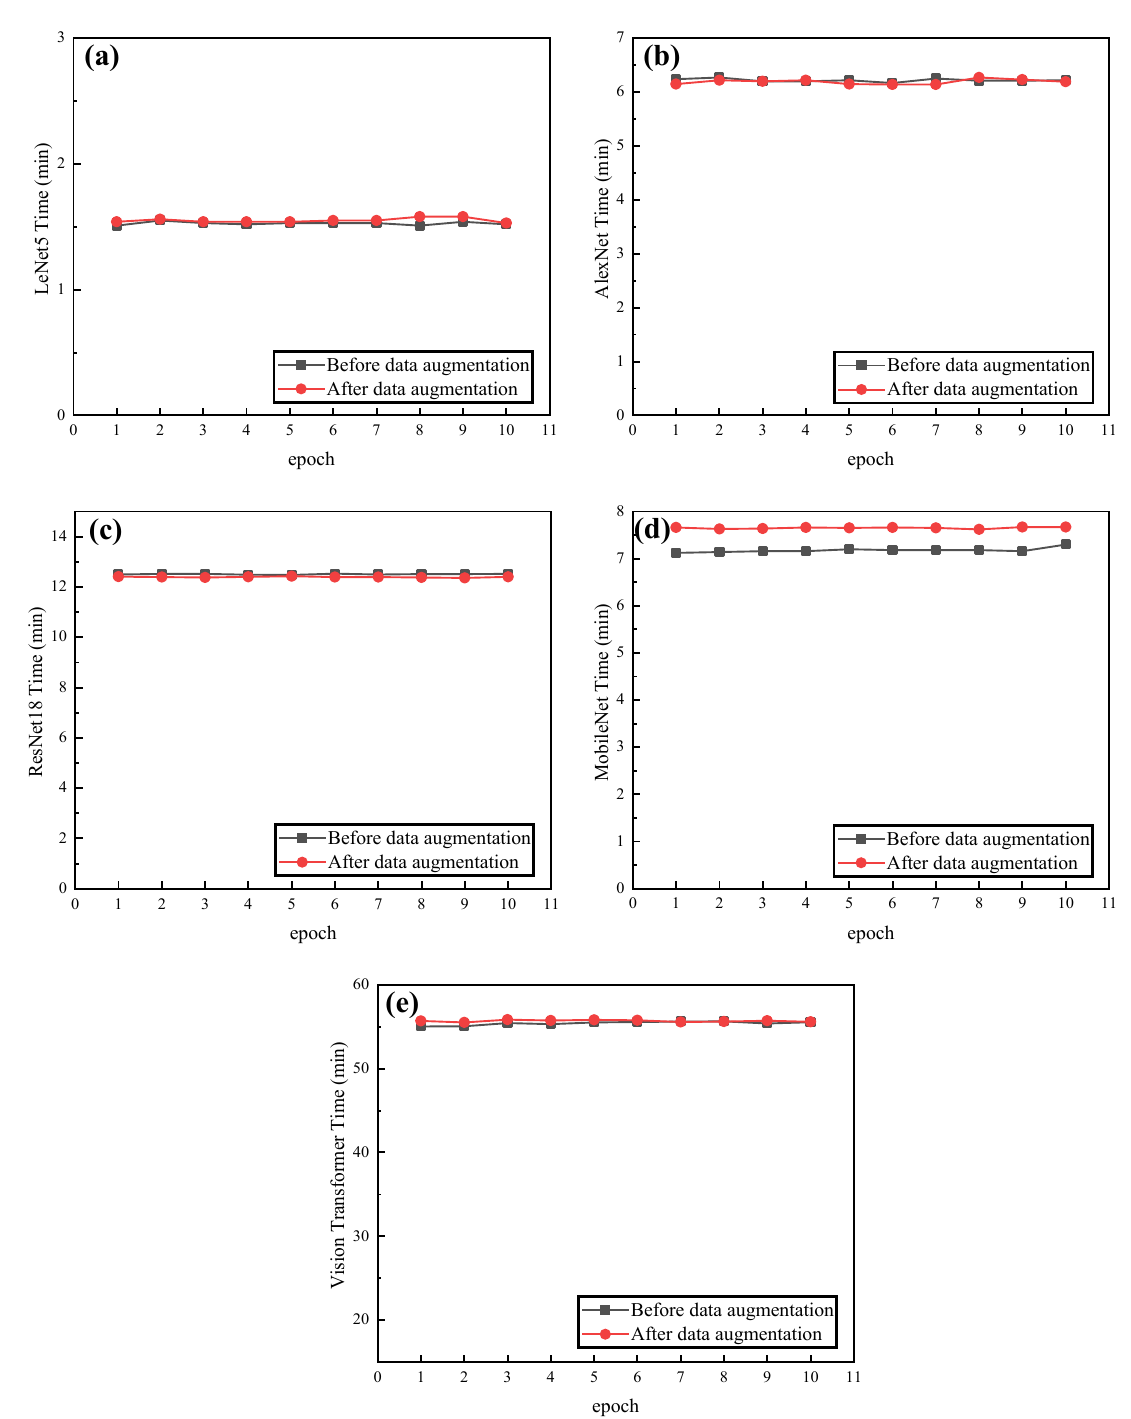
Figure 14. Comparison of the computational efficiency of each model before GPU loading before and after data augmentation. ( a ) Comparison of the computational efficiency of LeNet5 model. ( b ) Comparison of the computational efficiency of AlexNet model. ( c ) Comparison of the computa- tional efficiency of ResNet18 model. ( d ) Comparison of the computational efficiency of MobileNet model. ( e ) Comparison of the computational efficiency of Vision Transformer